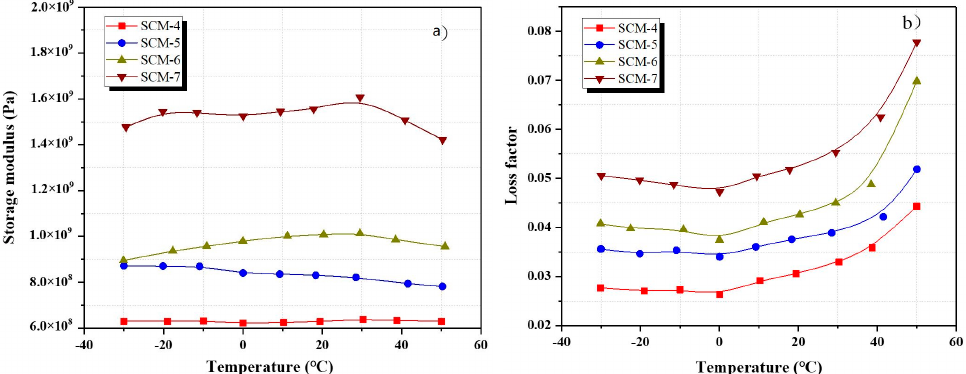
Figure 8. Dynamic mechanical analysis (DMA) analysis of samples under varying PVA fiber content and temperature for frequency of 0.5 Hz at 28 days: ( a ) Storage modulus; ( b ) loss factor.